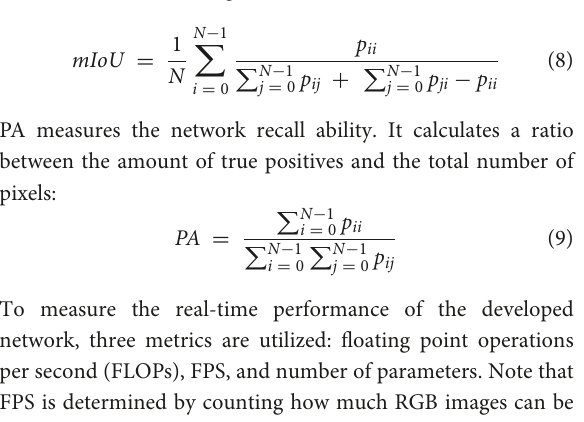
FIGURE3 Design details of FAM. Note that up refers to up-sampling by bilinear interpolation.